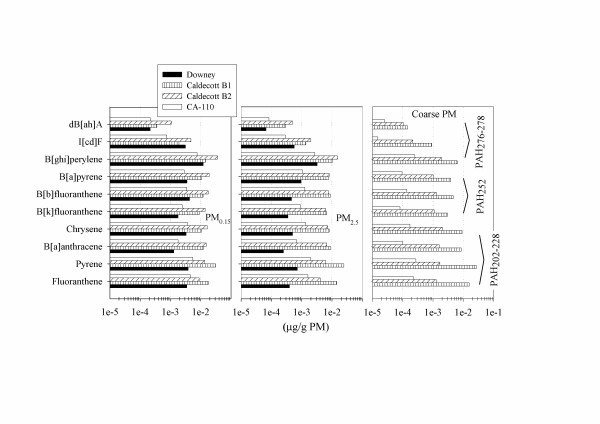
PAH content in size-fractionated PM samples, per sampling location. The PAHs have been grouped according to their molecular weight as schematically shown on the rightmost panel for all four sampling locations. Note the logarithmic scale on the x-axis. The highest PAH concentrations were found for samples collected in the tunnel. Interestingly, the concentration of heavier PAHs is higher in the gasoline-only tunnel bore while the PAH profile is shifted to relatively lighter components in the mixed gasoline-diesel bore.